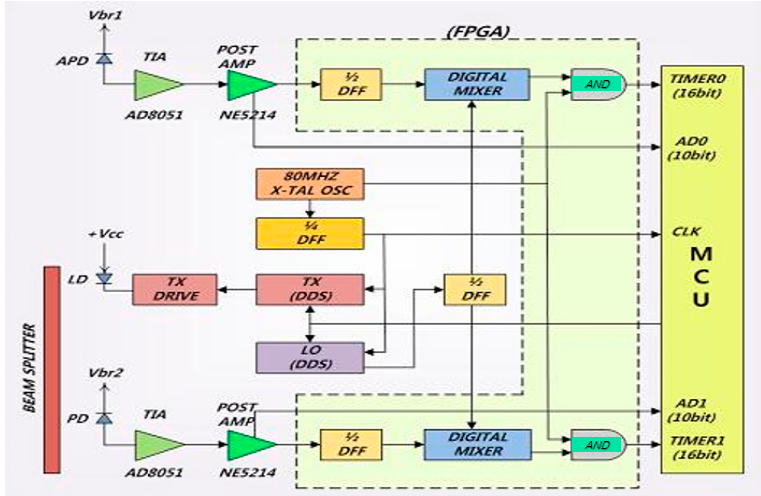
Figure 2. Basic configuration of the industrial optical sensor with high precision.